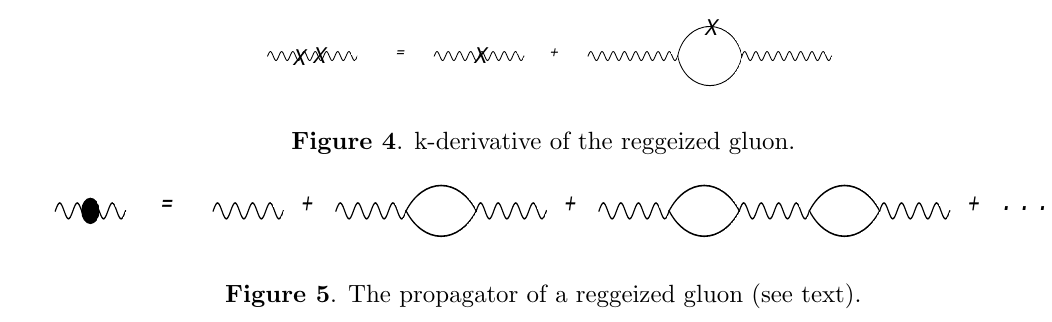
Figure 5 . The propagator of a reggeized gluon (see